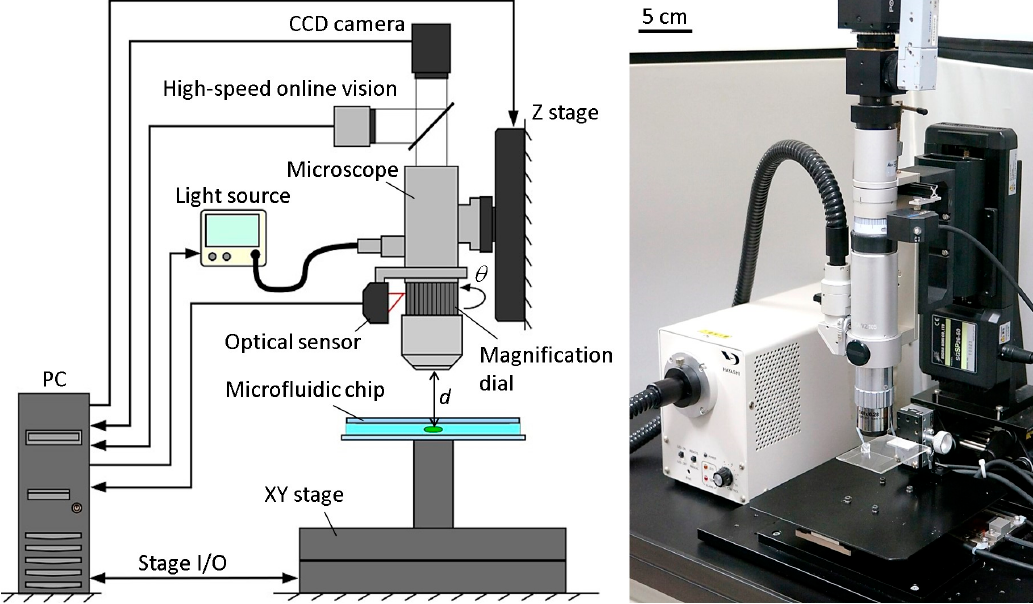
Figure 2. Main components of the developed platform. Windows 7 64-bit operating system (OS) was installed on a PC with 32 GB of physical memory. It was equipped with 16-bit AD/DA converter boards, 32-bit counter boards, and an FPGA board for a high-speed online vision sensor. d is the distance between the microscope lens and the target microorganism (the focal length), and θ is the rotational angle of the magnification dial. The relationship between the magnification ratio and the spatial resolution of the FOV for the high-speed online vision is as follows: [140× 210×, 280×, 420×, 560×, 700×, 840×, 980×, 1120×, 1400×] = [5.50, 4.80, 3.50, 2.20, 1.66, 1.29, 1.09, 0.92, 0.85, 0.79][µm/pixel]. The CCD camera’s FOV dimensions ranged from 1907 µm × 1073 µm to 231 µm × 130 µm for magnification ratios ranging from 140× to 1400×.